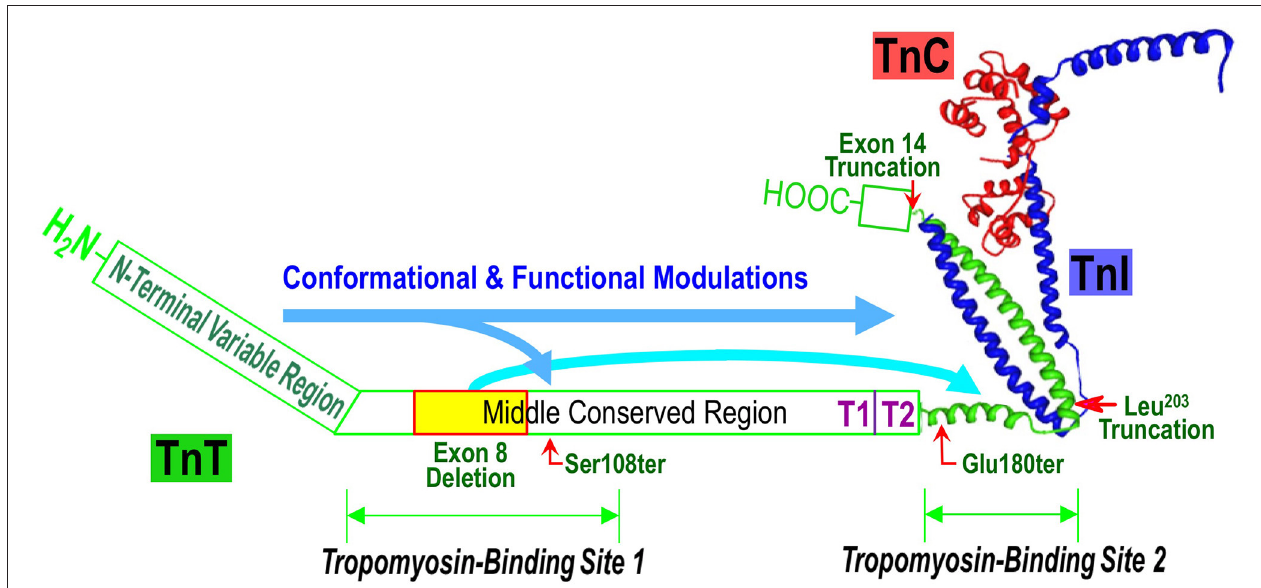
FIGURE 1 | Structural and functional domains of TnT and TNNT1 NM mutations. Illustrated on a structure-function model of the troponin complex (the crystallographic structure was adapted from Takeda et al., 2003), the positions of slow TnT Ser 108 , Glu 180 , Leu 203 and exon 14 truncations and exon 8 deletion are indicated together with the interaction sites for tropomyosin (Tm), TnI and TnC. The long arrows propose the effects of N-terminal variable region on the overall conformation and function of TnT. In this model, the effect of N-terminal segment on decreasing Tm-binding affinity was augmented by the internal deletion of the exon 8-encoded